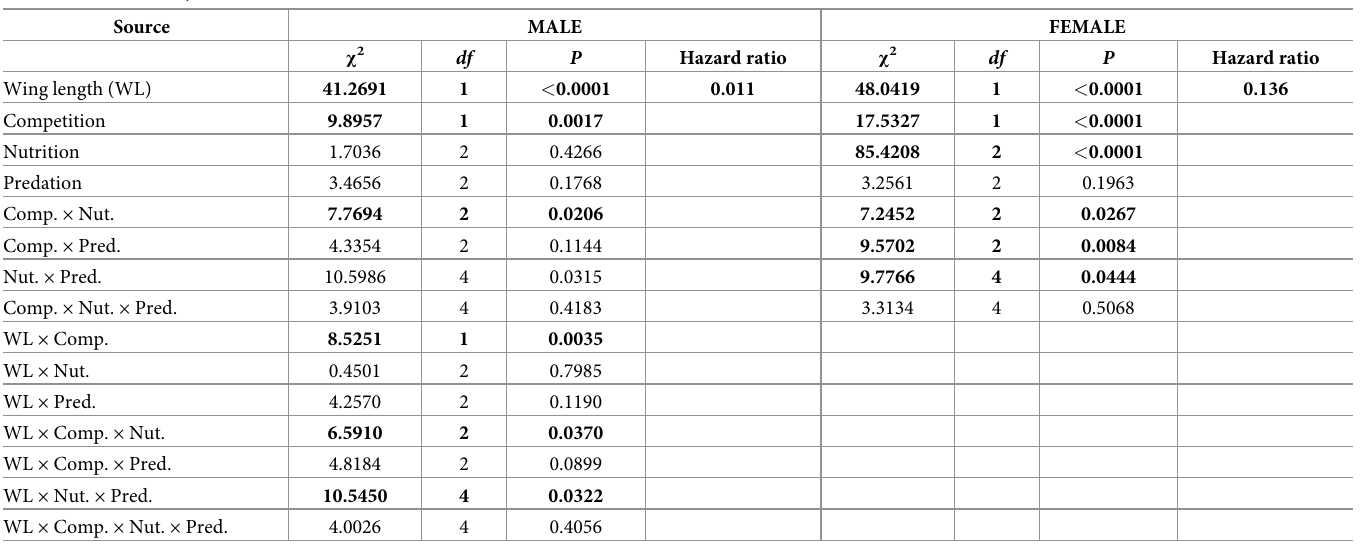
Table 4. Survival analysis.